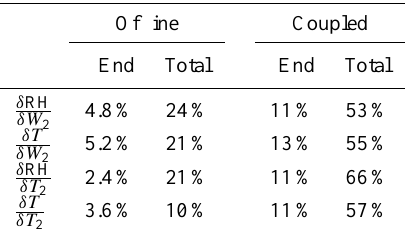
Table 1. Percentage of grid points at which an oscillation occurs at the end of the run (thus influencing the Jacobian value) and in total (i.e. including those during the run that do not influence the Jacobian value). Offline